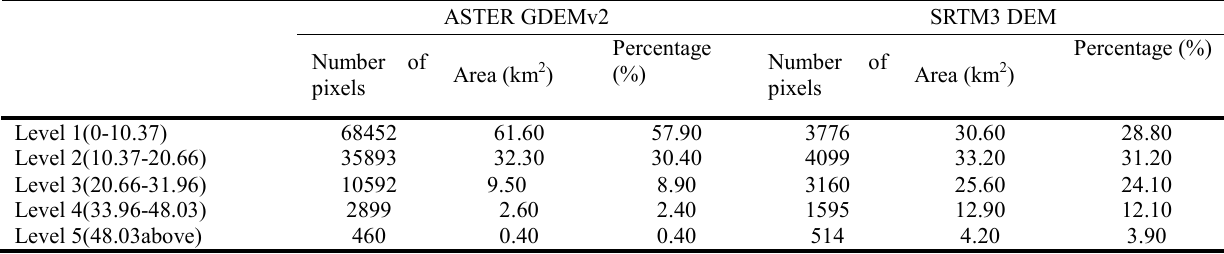
NOTE ： ASTER GDEMv2 372*318 pixels Table 4 ASTER GDEM, SRTM3 DEM and WorldDEM data elevation difference statistics in test area B